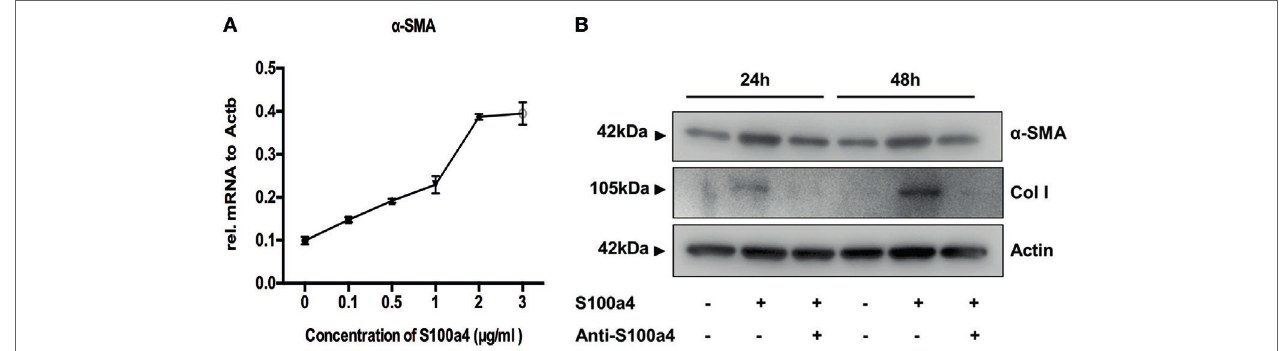
FigUre 4 | S100a4 promotes activation of lung fibroblasts. (a) Primary lung fibroblasts were treated with various concentrations of recombinant S100a4 (0–3 µg/ ml) for 24 h, and expression of α -SMA was assessed by qRT-PCR. Results are mean ± SD of duplicate samples from one experiment. (B) Cells were treated with 2 µg/ml recombinant S100a4 or with recombinant S100a4 in the presence of a S100a4 neutralizing antibody for 24 and 48 h, respectively. Cells were harvested and analyzed for expression of α -SMA and collagen I by western blot. S100a4 neutralization eliminated activation of lung fibroblasts. Results are representative of three independent experiments with similar results.